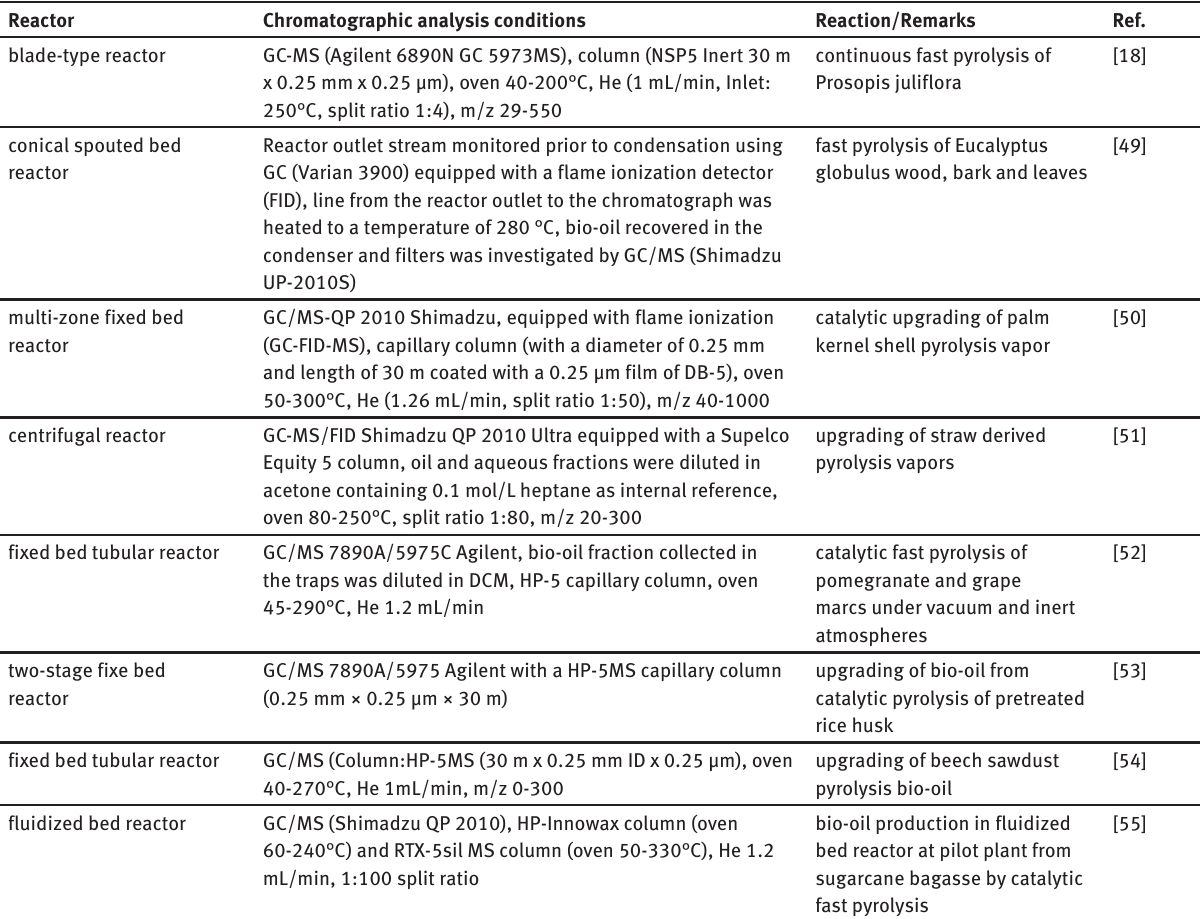
Table 4 Fast pyrolysis of lignocellulosic feedstock performed with the use of various reactors